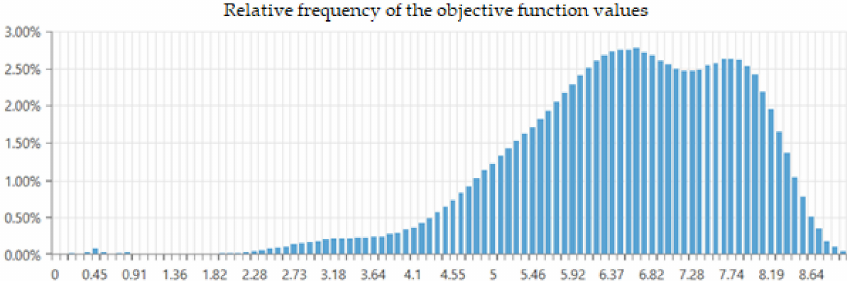
Figure 15. The percentage of relative frequency of the objective function